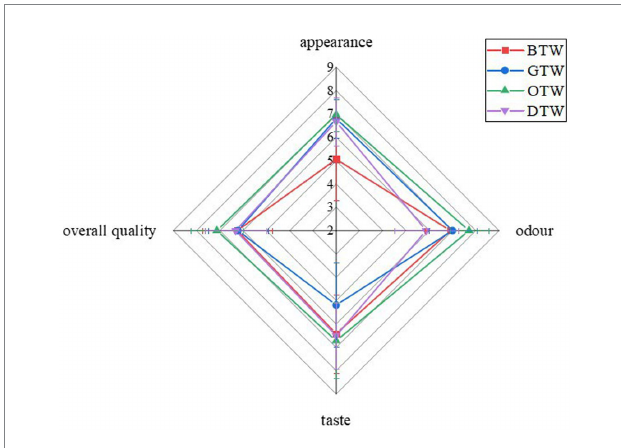
FIGURE 5 The sensory property evaluation on tea